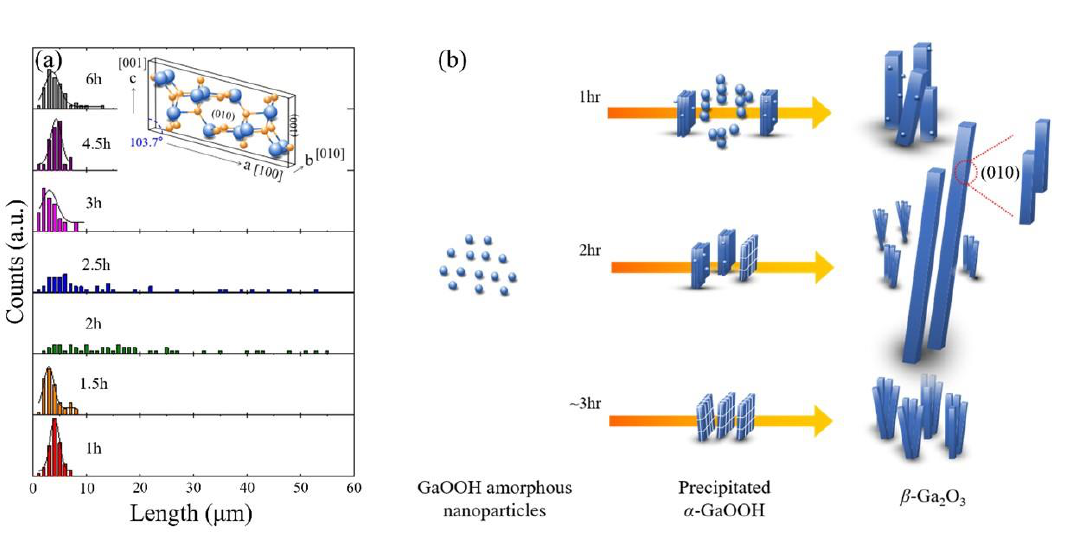
Figure 5. ( a ) Histogram of the size distribution and ( b ) proposed growth mechanism of β-Ga 2 O 3 nanorods depending at different aging times. Under the insufficient aging time (below 2 h in these experimental conditions), the uncompleted nanoparticles prevented the attachment of the spindle-like nanorods parallel to the plane, causing a prism-like nanord with nanoparticles. On the other hand, under the excessive aging time (above 3 h in these experimental conditons), the precipitated nanorods with smooth surfaces were continually and repeatedly dissolved and re-assembled in the supersaturated solution. The re-assembled nanorods at longer aging times presumably possessed more defects and mismatches, which also prevented the attachment of nanorods parallel to the plane and caused the crystal to split, leading to bundles of small nanorods of split structures.